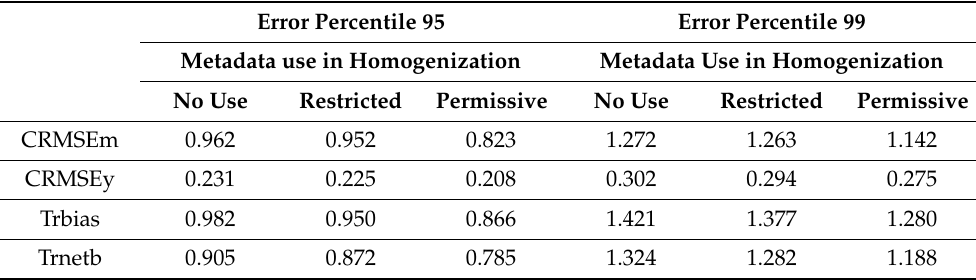
Table 2. Impact of metadata use on the upper tail of the probability distribution of residual errors after